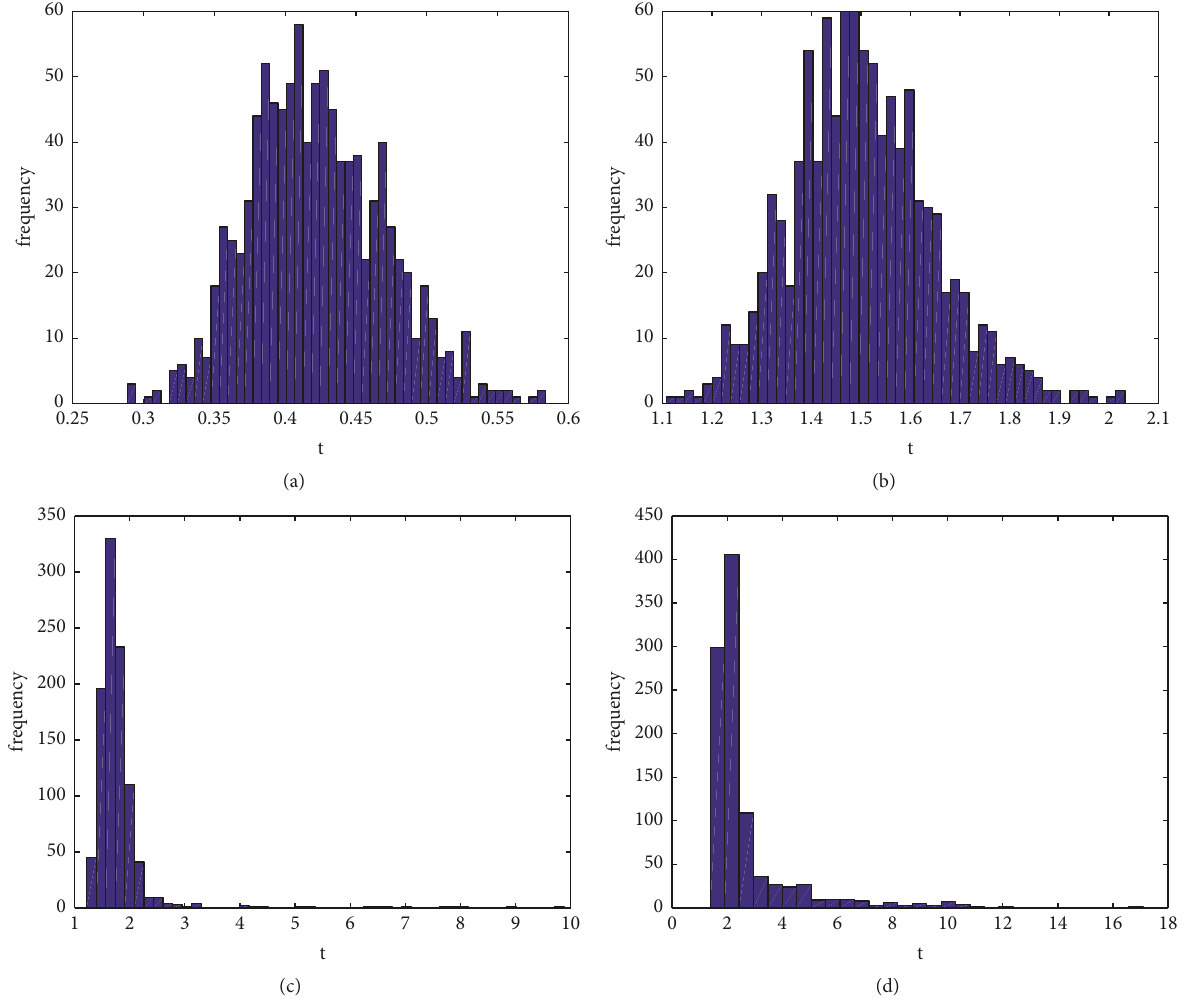
Figure 8: The effects of the control measures on pest-outbreak frequency; parameters are fixed as 𝑟 = 1, 𝐾 = 10,𝑎 = 2, 𝜇 = 0.2,𝐷 = 0.1, 𝐸𝑇 = 7.5,𝛼 = 0.2,𝛼 = 0.25 , and (a) 𝜃 = 0.1, 𝜏 = 0 ; (b) 𝜃 = 0.4, 𝜏 = 0 ; (c) 𝜃 = 0.4, 𝜏 = 0.2 ; (d) 𝜃 = 0.4,𝜏 = 0.5 1 2